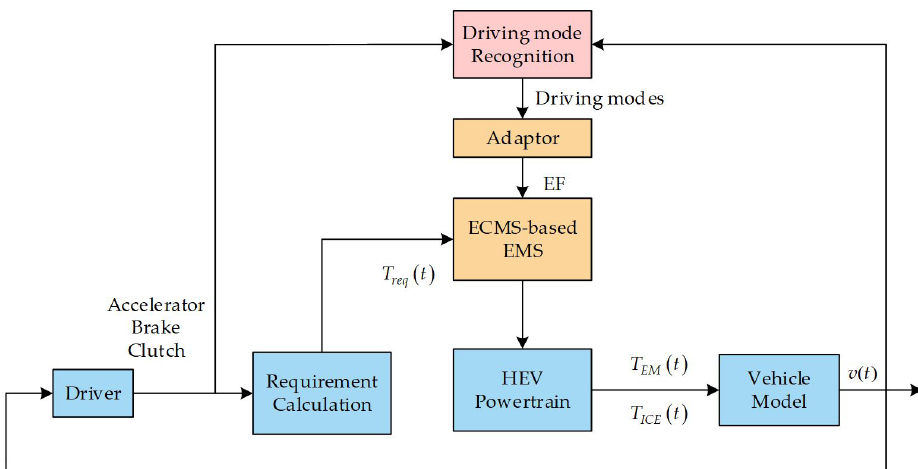
Figure 8. Flow chart of the driving condition predictive model.